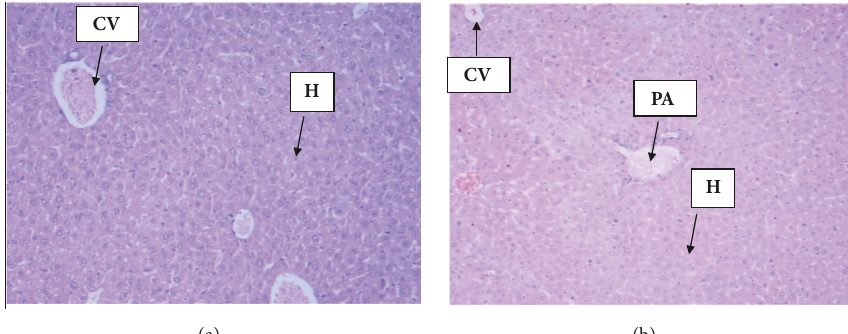
Figure 3: Photomicrographs (H&E, magnification x 4) of liver histology. (a) Control group liver section showed normal hepatocytes; (b) Section of liver from L. angustifolia EO (2000 mg/kg) treated group depicted normal hepatocytes architectureafter 21 days of administration. CV=Central Vein, H= Hepatocytes, PA=Portal Area.